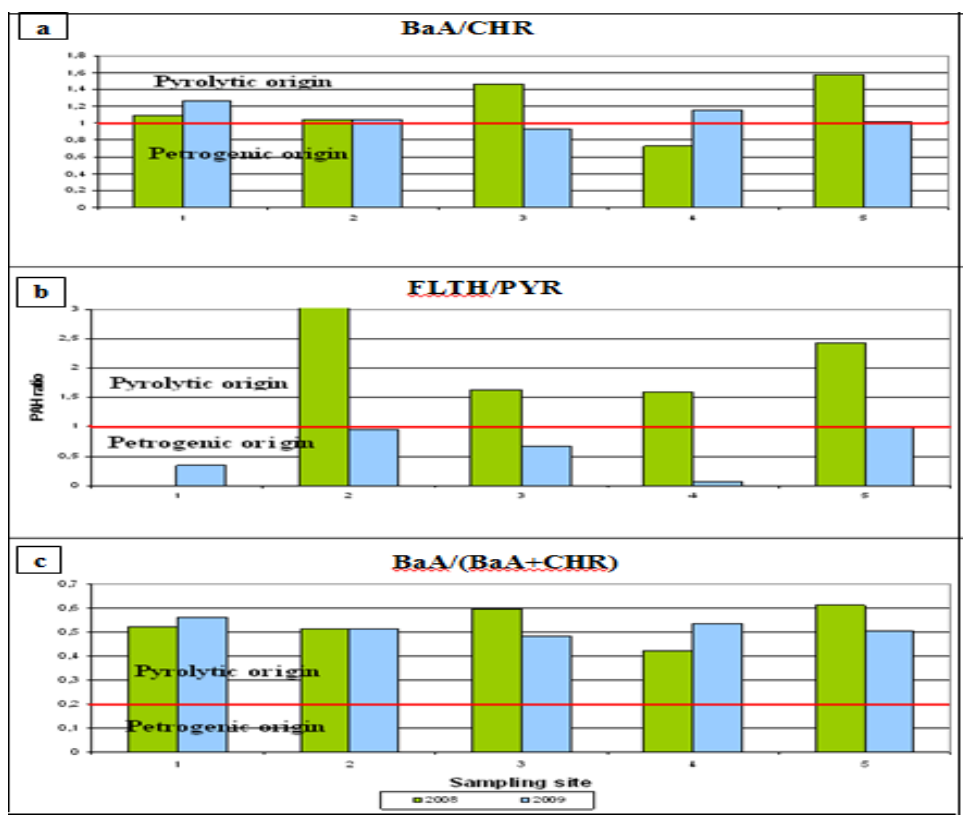
Figure 5. PAH isomer ratios for source indicators: ( a ) BaA/CHR; ( b ) FLTH/PYR; ( c ) BaA/(BaA + CHR). PAH isomer ratios were calculated for five sampling sites